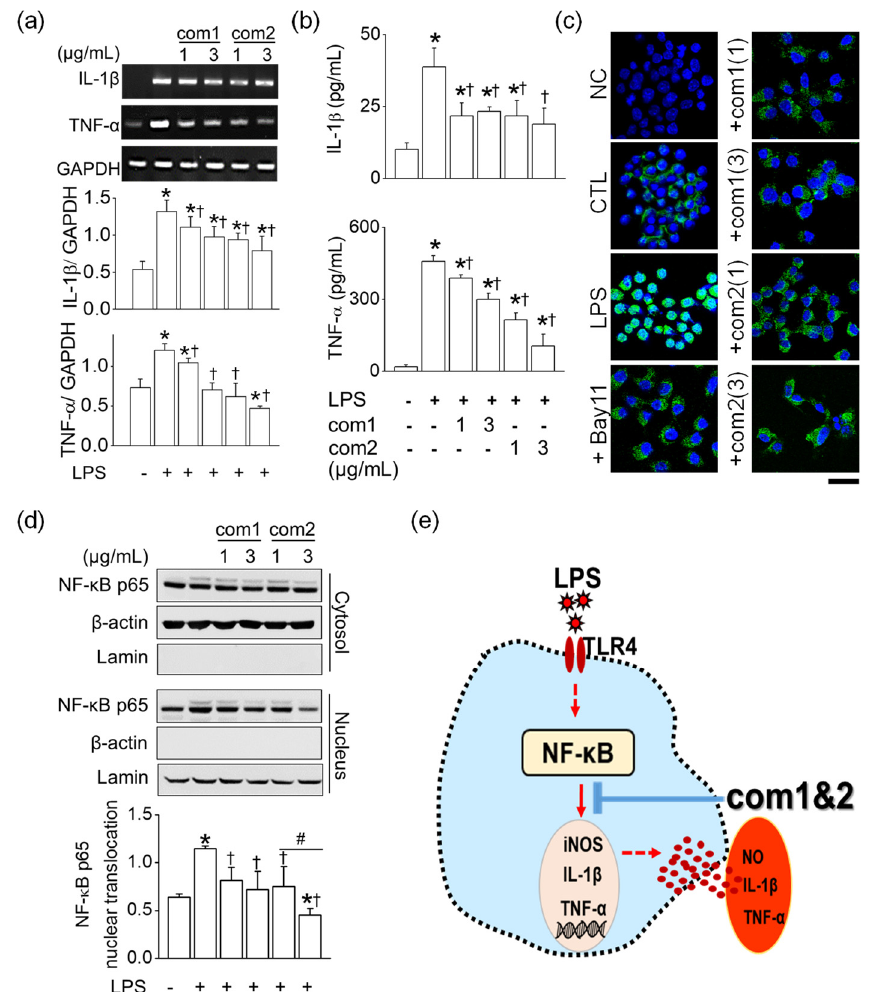
Figure 6. Suppression of pro-inflammatory cytokines through blocking NF- κ B pathway by iridal- type triterpenoids in LPS-stimulated RAW264.7 cells. ( a , b ) Down-regulation of IL-1 β and TNF- α mRNA expression and concentration by triterpenoids. ( c , d ) Suppression of LPS-induced nuclear translocation of NF- κ B p65 upon treatment with triterpenoids confirmed by immunocytochemistry and Western blotting assay, respectively. NC represents negative control without primary antibody treatment. CTL, LPS, and Bay 11 represent control, lipopolysaccaride, and Bay11-7085, respectively. Bay11-7085 was used as an inhibitor of NF- κ B p65 translocation. Scale bar, 20 µm. The plus and minus signs (+ and − ) indicate conditions with and without treatment, respectively. ( a , b , d ) * p < 0.05 compared to control (no treatment with LPS); † p < 0.05 compared to LPS alone treatment; # p < 0.05 compared to the 1 µ g/mL of compound 2 . ( e ) Schematic representation of anti-inflammatory signals in LPS-stimulated RAW264.7 cells by